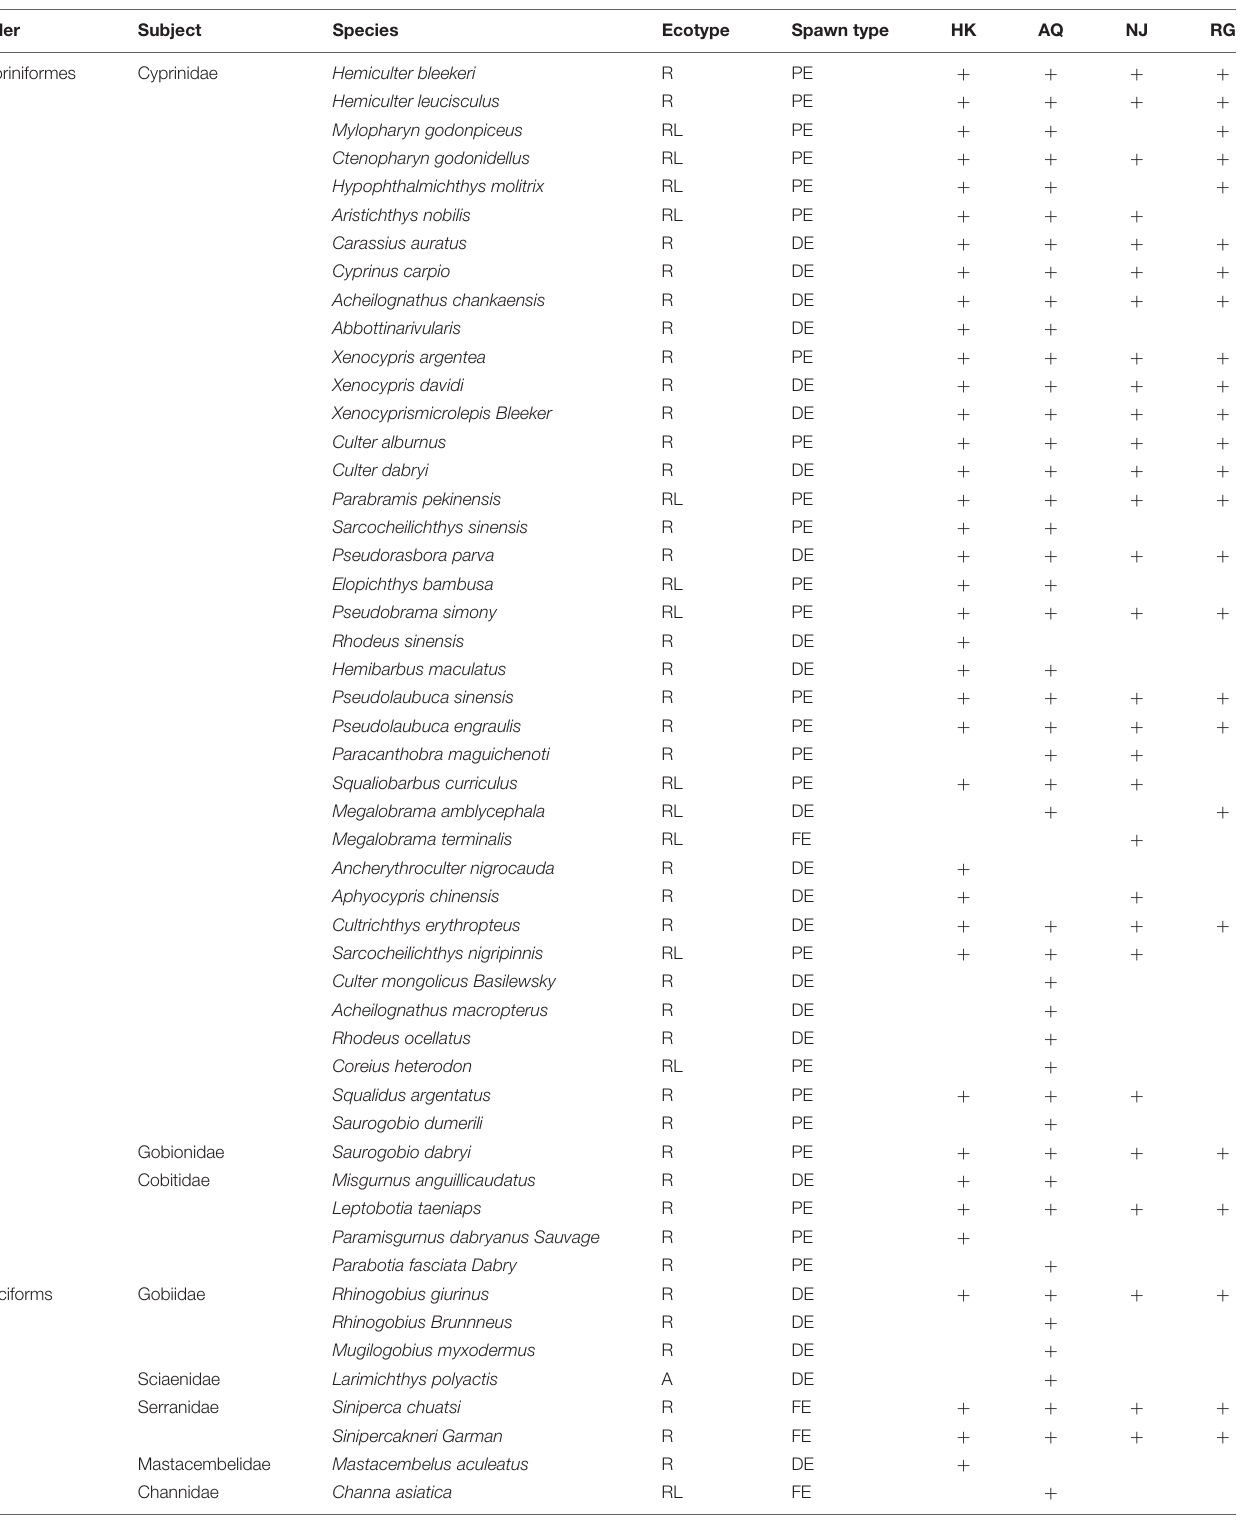
TABLE 1 | Abundance of ichthyoplankton in each